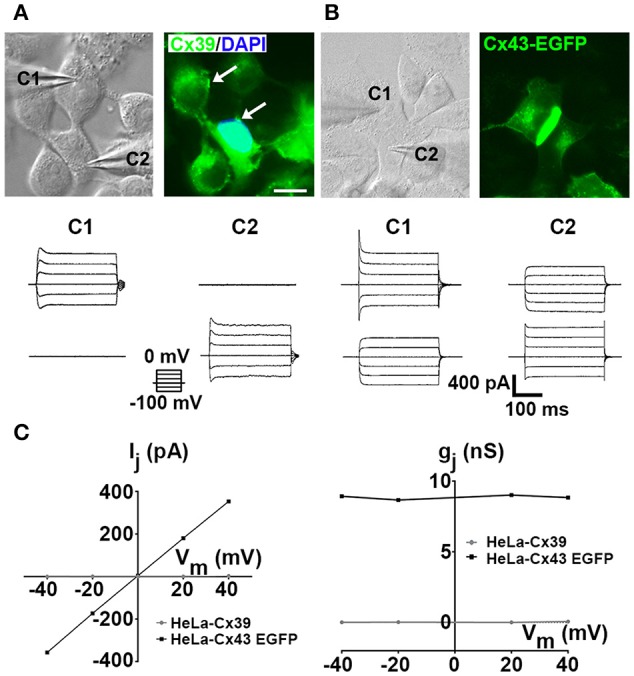
HeLa-Cx39 cells do not form functional gap junctions. (A,B) Phase contrast view (left) and immunofluorescence of Cx39 (A, right) and Cx43-EGFP fluorescence (Right) in HeLa-Cx39 and fluorescence of HeLa-Cx43EGFP cells (B, right). Bar scale: 20 μM. Arrows denote small Cx39 gap junctions plaques. (C) Junctional current (Ij) at different voltages (left) and normalized junctional conductance (gj) at different voltages (right) using dual voltage-clamp measurements in HeLa-Cx39 and HeLa-Cx43EGFP cells. Values of Ij for HeLa-Cx39 cells were zero at all voltages studied. Records of intercellular current transfer from cell1 (C1) to cell2 (C2) and vice versa in HeLa-Cx39 cells (Below cells shown in A) and in HeLa-Cx43EGFP (Below cells shown in B) upon voltage steps (increasing in 20 mV from −100 to 0 mV with duration of 200 ms, left bottom traces) applied to C1 and C2, respectively (n = 9).